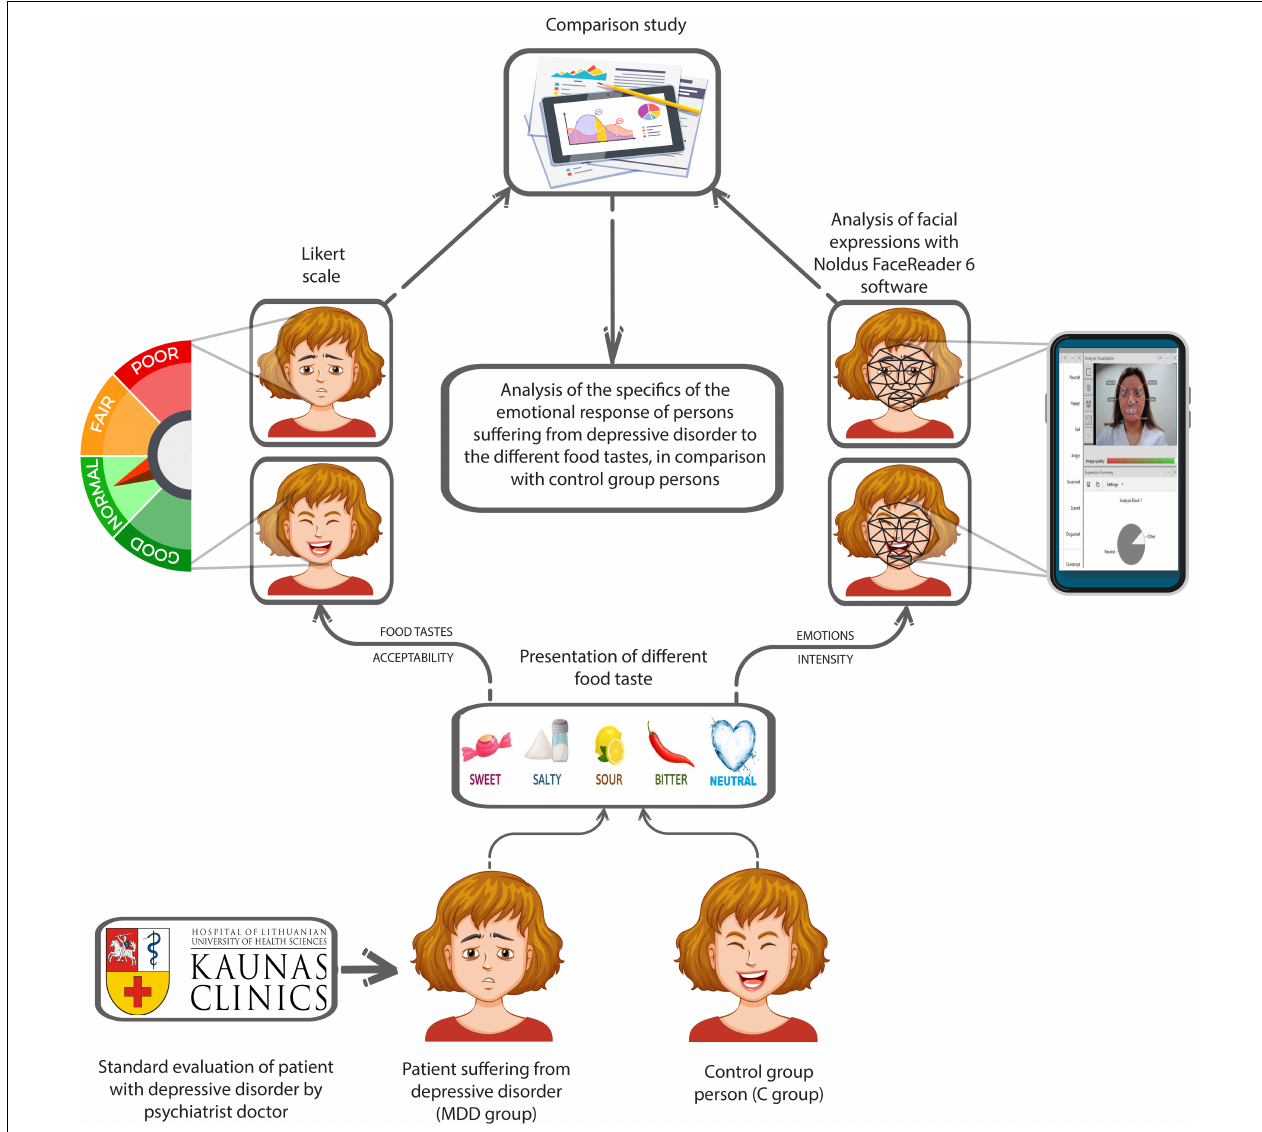
FIGURE 1 | Principal scheme of the experiment (MDD – major depressive